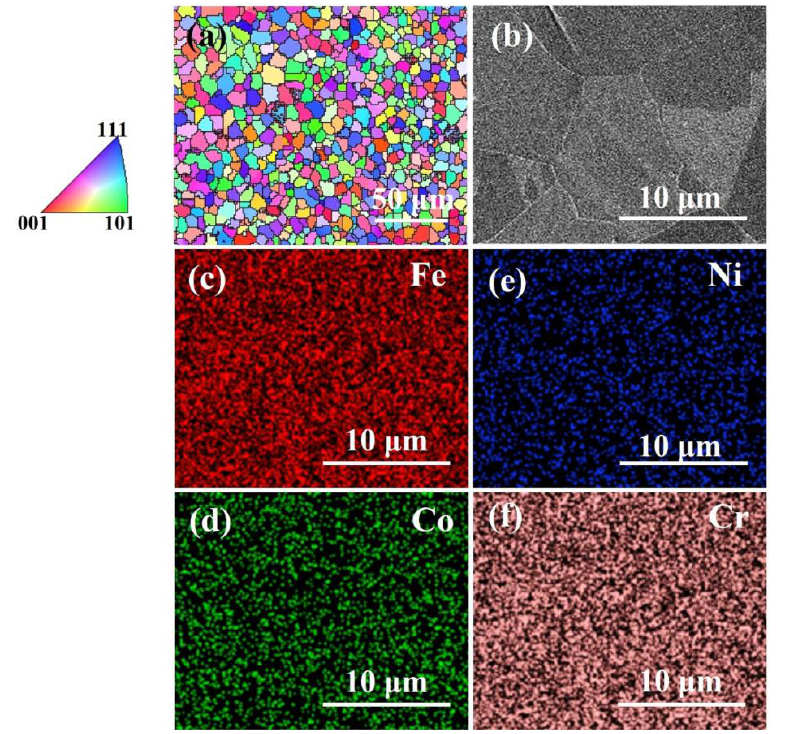
Figure 9. ( a ) EBSD IPF map of the 1000 °C annealed CoCrFeNi coating. ( b ) A typical SEM